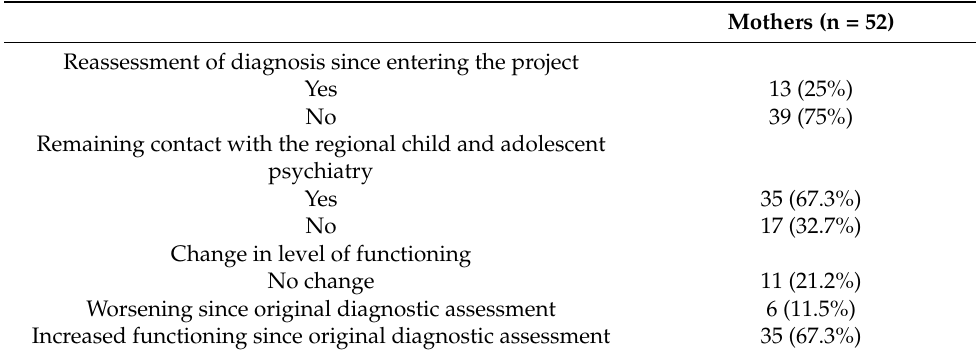
Table 2. Information related to the diagnostic process.